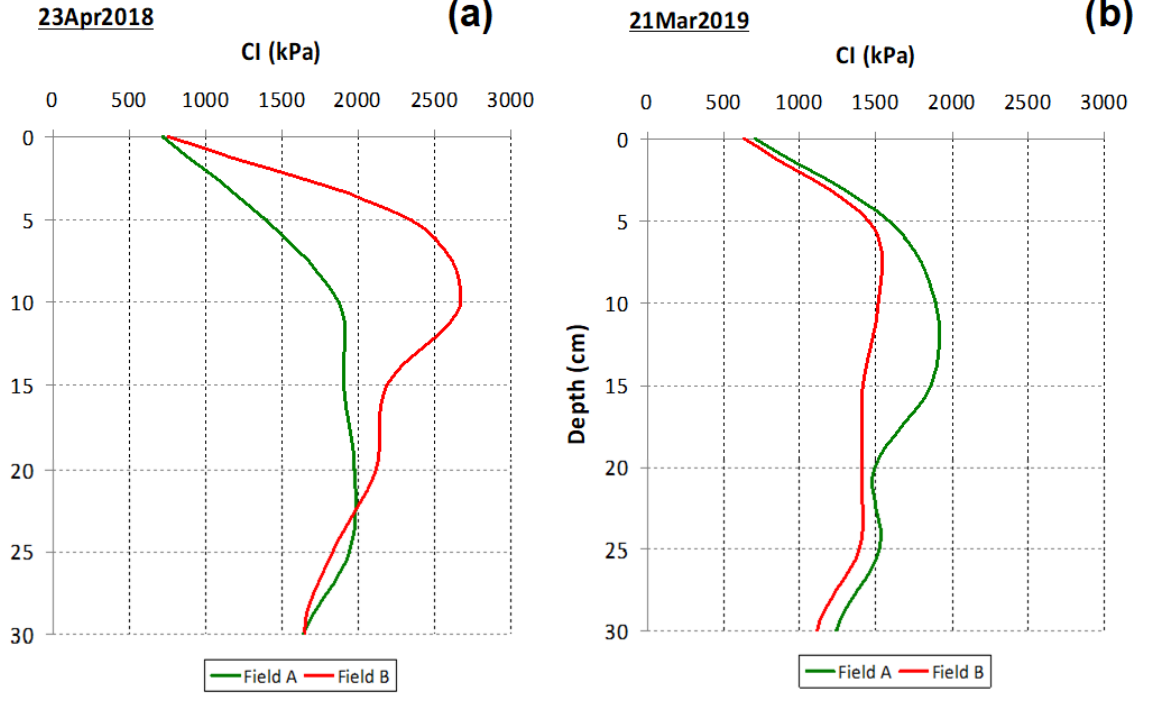
Figure 10. Average Cone Index (CI) at 0 –0.30 m soil depth, in “Field A” and “Field B”: ( a ) 2018; ( b ) 2019.